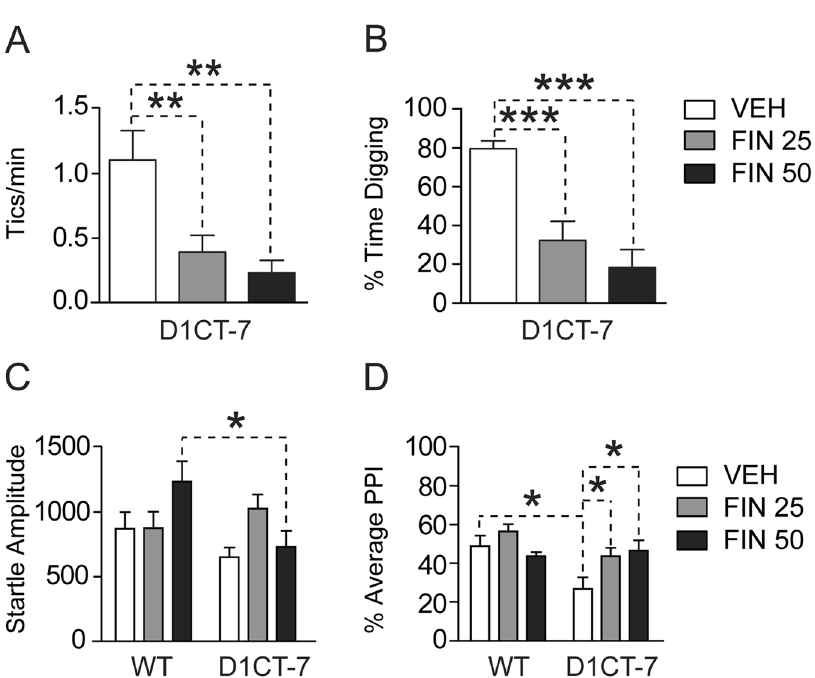
Figure 6. Effects of finasteride (FIN; 25–50 mg/kg, IP) on behavioral phenotypes related to Tourette syndrome. Data are shown as means ± SEM. * P < 0.05, ** P < 0.01 and *** P < 0.001 for comparisons indicated by dashed lines. Doses are indicated in mg/kg (IP). N = 8/group. VEH, vehicle; WT, wild-type; PPI, prepulse inhibition of the startle. For further details, see